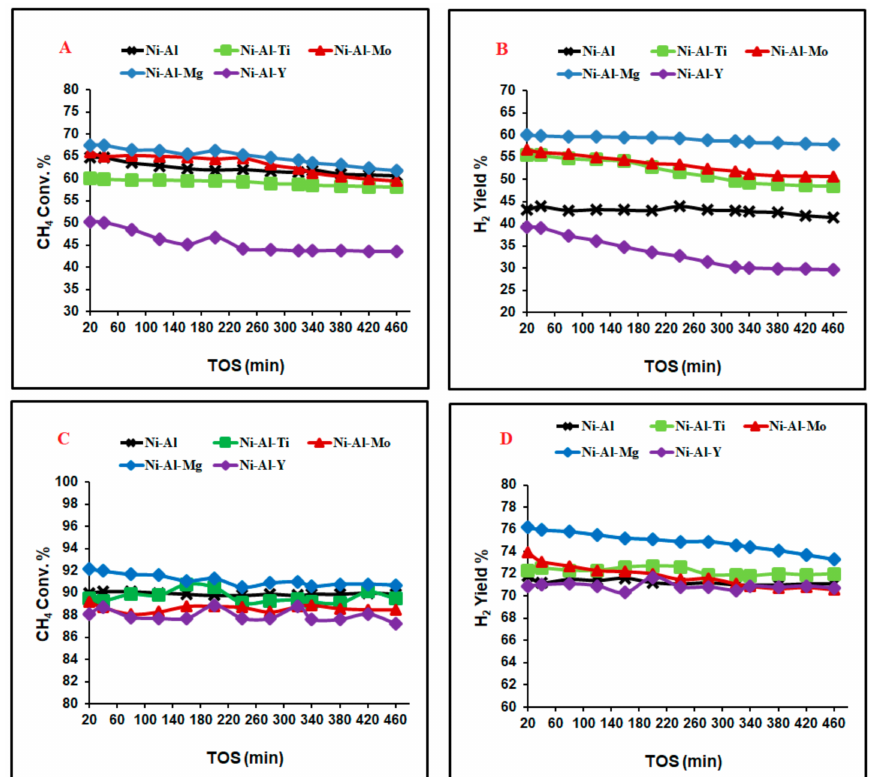
Figure 3. ( A ) CH 4 conversions reaction temperature 550 ◦ C; ( B ) hydrogen yield reaction temperature 550 ◦ C; ( C ) CH 4 conversions reaction temperature 650 ◦ C; ( D ) hydrogen yield reaction temperature